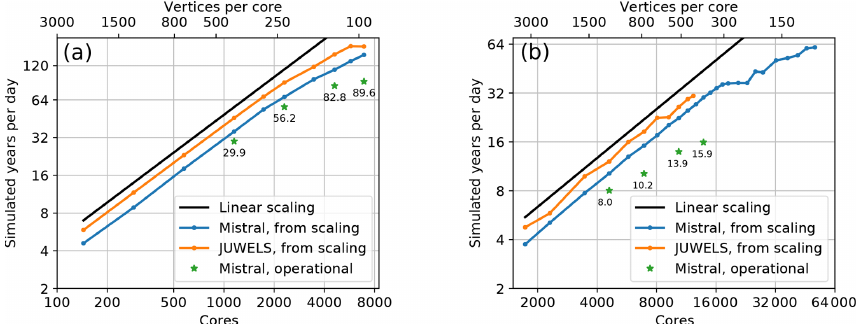
Figure 10. Model throughput in simulated years per day (SYPD) estimated from scaling experiments and measured in 1-year experiment with I/O for fArc (a) and STORM (b)